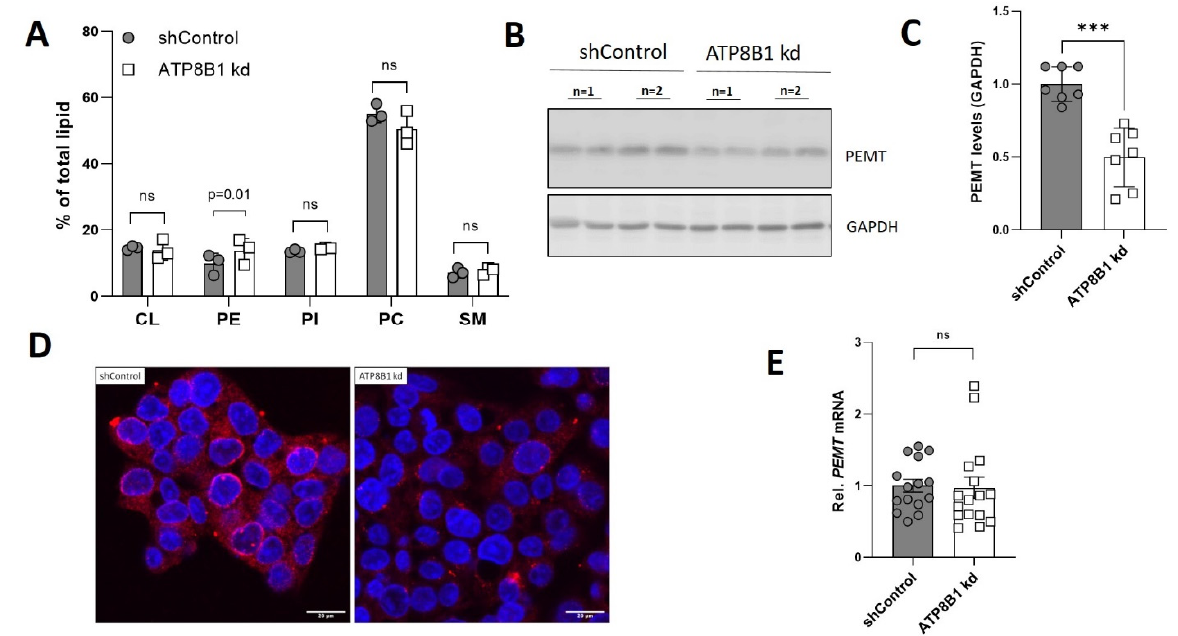
Figure 5. ATP8B1 knockdown cells have increased mitochondrial phosphatidylethanolamine content and reduced phosphatidylethanolamine N-methyltransferase (PEMT) levels. ( A ) Mitochondrial lipid species expressed as percentage of total mitochondrial lipid. Data are expressed as mean +/ − s.d. of 3 independent mitochondria isolations. Statistical analysis by multiple unpaired t -test; ( B ) Representative Western blot showing PEMT protein levels in total cell lysates of control and ATP8B1 knockdown HepG2 cells; ( C ) Densitometric analysis of PEMT levels; data are expressed as mean +/ − s.d. of 6 replicates from 3 independent experiments. Statistical analysis by an unpaired t -test. *** p = 0.0001; ( D ) Confocal analysis of PEMT staining in red and nuclear dapi in blue. Bar = 20 nm; ( E ) PEMT mRNA expression in ATP8B1 knockdown HepG2 cells. Data were normalized to shControl cells and are expressed as means +/ − s.e.m. of 15 replicates from 5 independent experiments. Statistical analysis by an unpaired t -test.